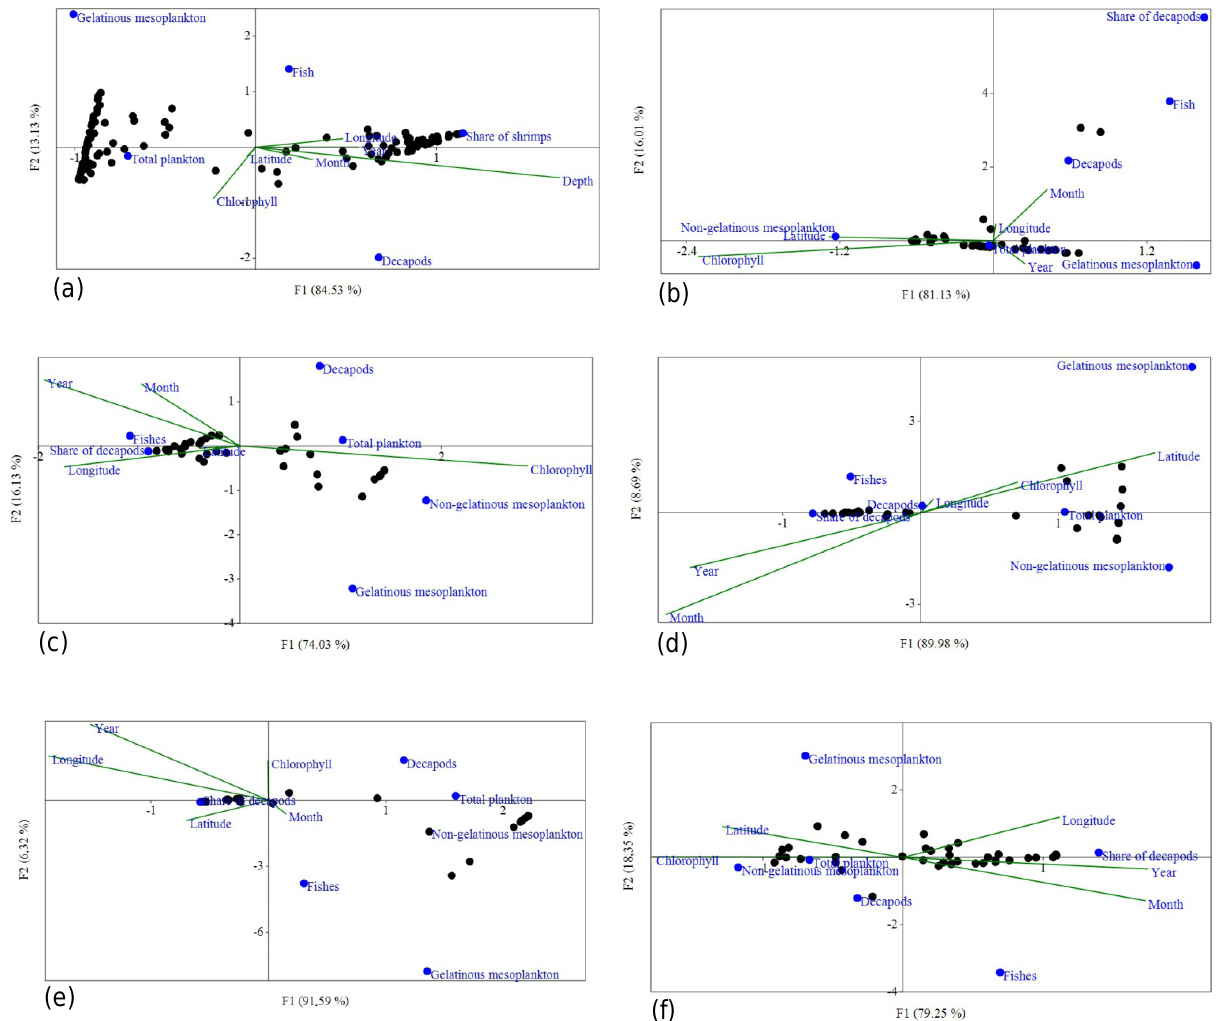
Figure 4. CCAs with all hauls included (a) , with hauls taken in the epipelagic zone (b) , in the main thermocline (c) , in the upper (d) and in the lower (e) bathypelagic zones, and in the whole water column (f) . The two first axes (F1 and F2) are shown with their respective explained